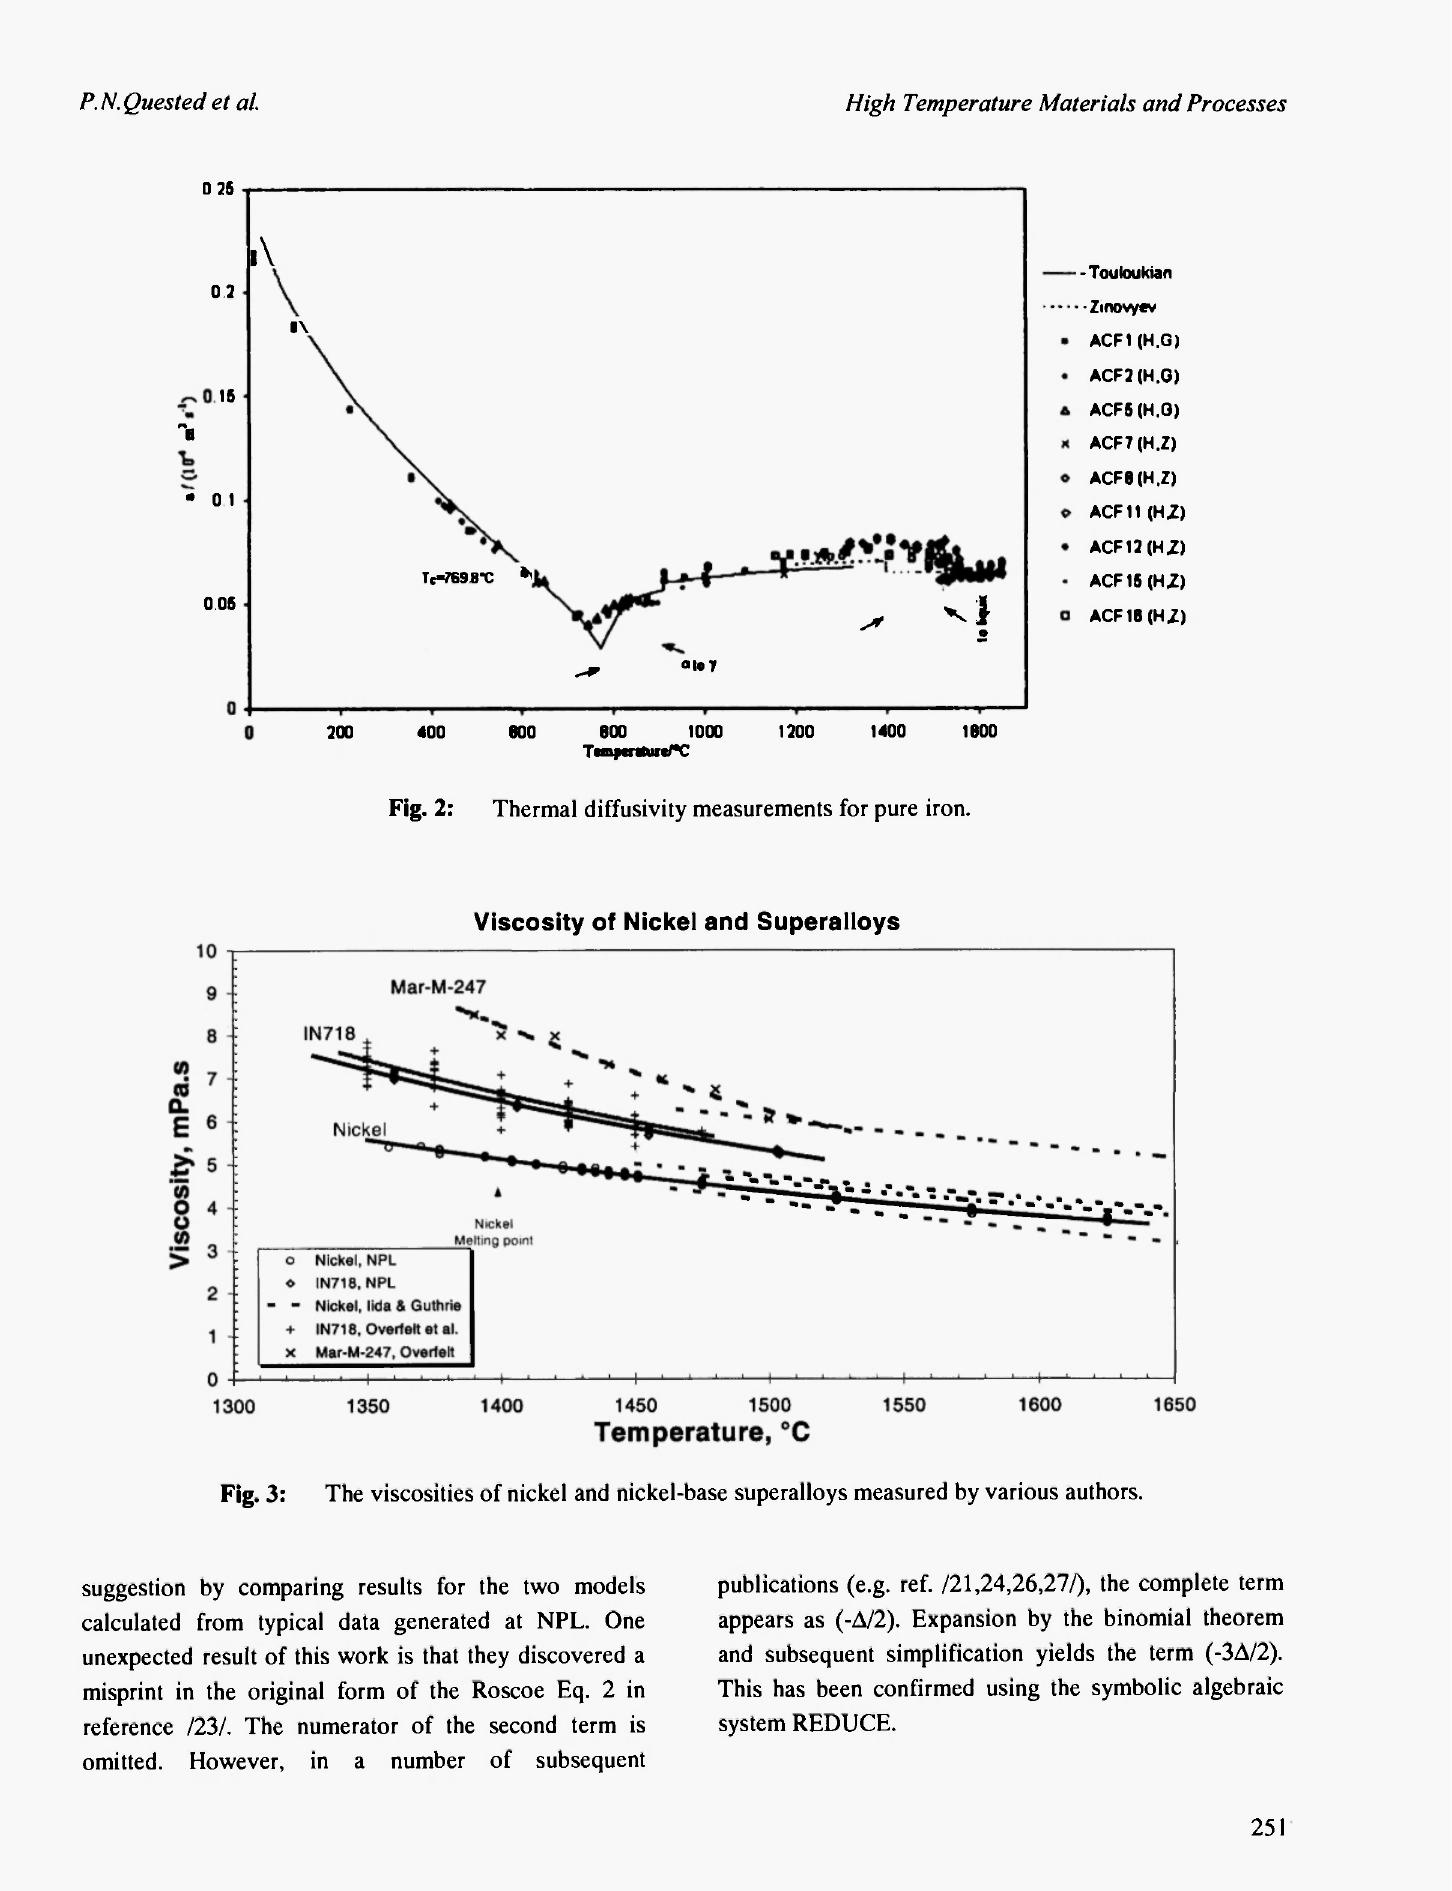
publications (e.g. ref. /21,24,26,27/), the complete term appears as (-Δ/2). Expansion by the binomial theorem and subsequent simplification yields the term (-3Δ/2). This has been confirmed using the symbolic algebraic system REDUCE.